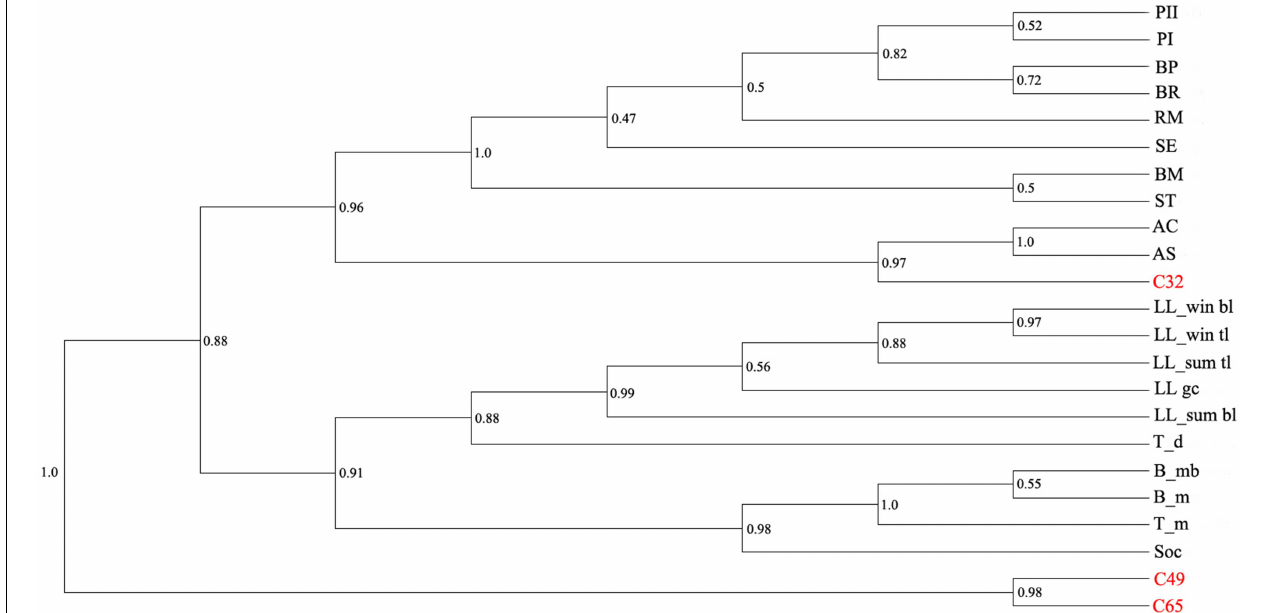
SRR350006; Centeno et al., 2012); LL_win bl, Salar de Llamara winter sample, bottom layer; LL_win tl, Salar de Llamara winter